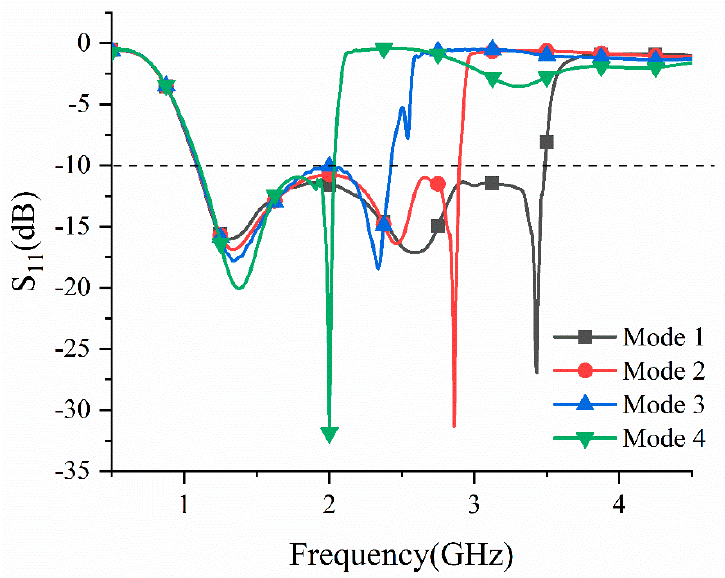
Figure 6. The simulated frequency response of the proposed antenna for each mode.